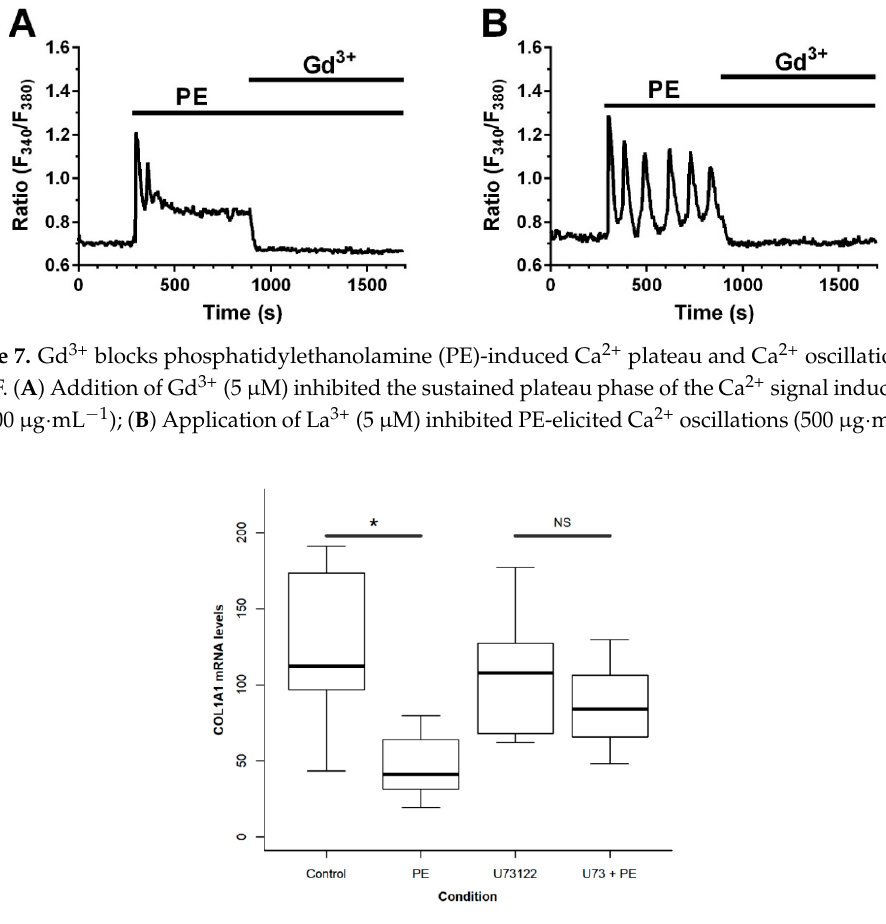
Figure 6 . Statistical analysis of Ca 2+ imaging experiments. Mean ± SE of the amplitude of the Ca 2+ response to PE 500 µg·mL − 1 under the designated treatments. Asterisks denote significant differences ( p < 0.05, ANOVA with post-hoc Dunnett test against the control).